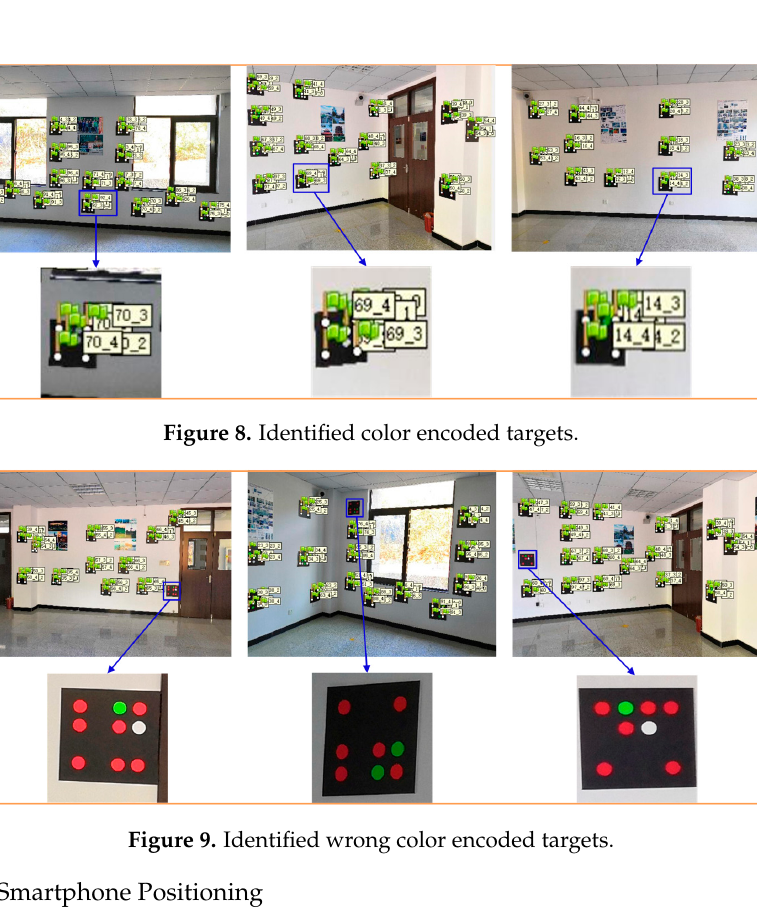
Figure 7. Point cloud 3D display of color encoded targets and feature points.